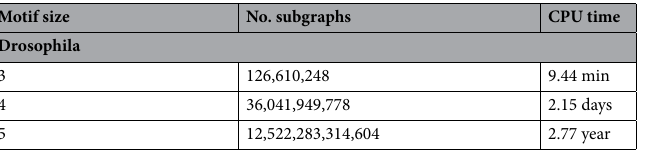
Table 5. Computational complexity. The number of subgraphs, and the corresponding amount of time needed for enumeration, greatly increases as k increases on large connectomes.